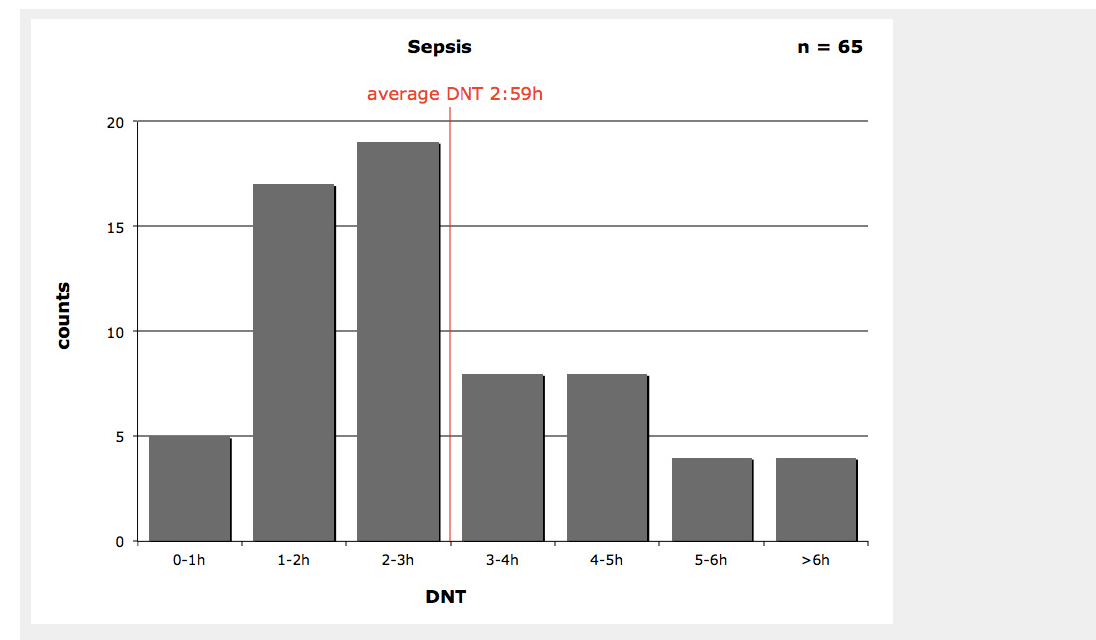
Figure 4 Average door-to-needle-time (DNT) in sepsis